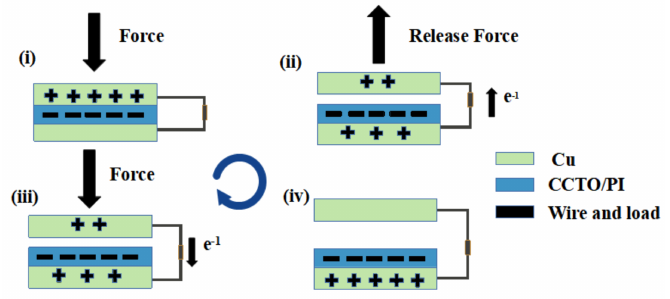
Figure 7. The structure and working mechanism of CS − TENG. ( i ) initial state. ( ii ) release state. ( iii ) press state. ( iv ) equilibrium state.